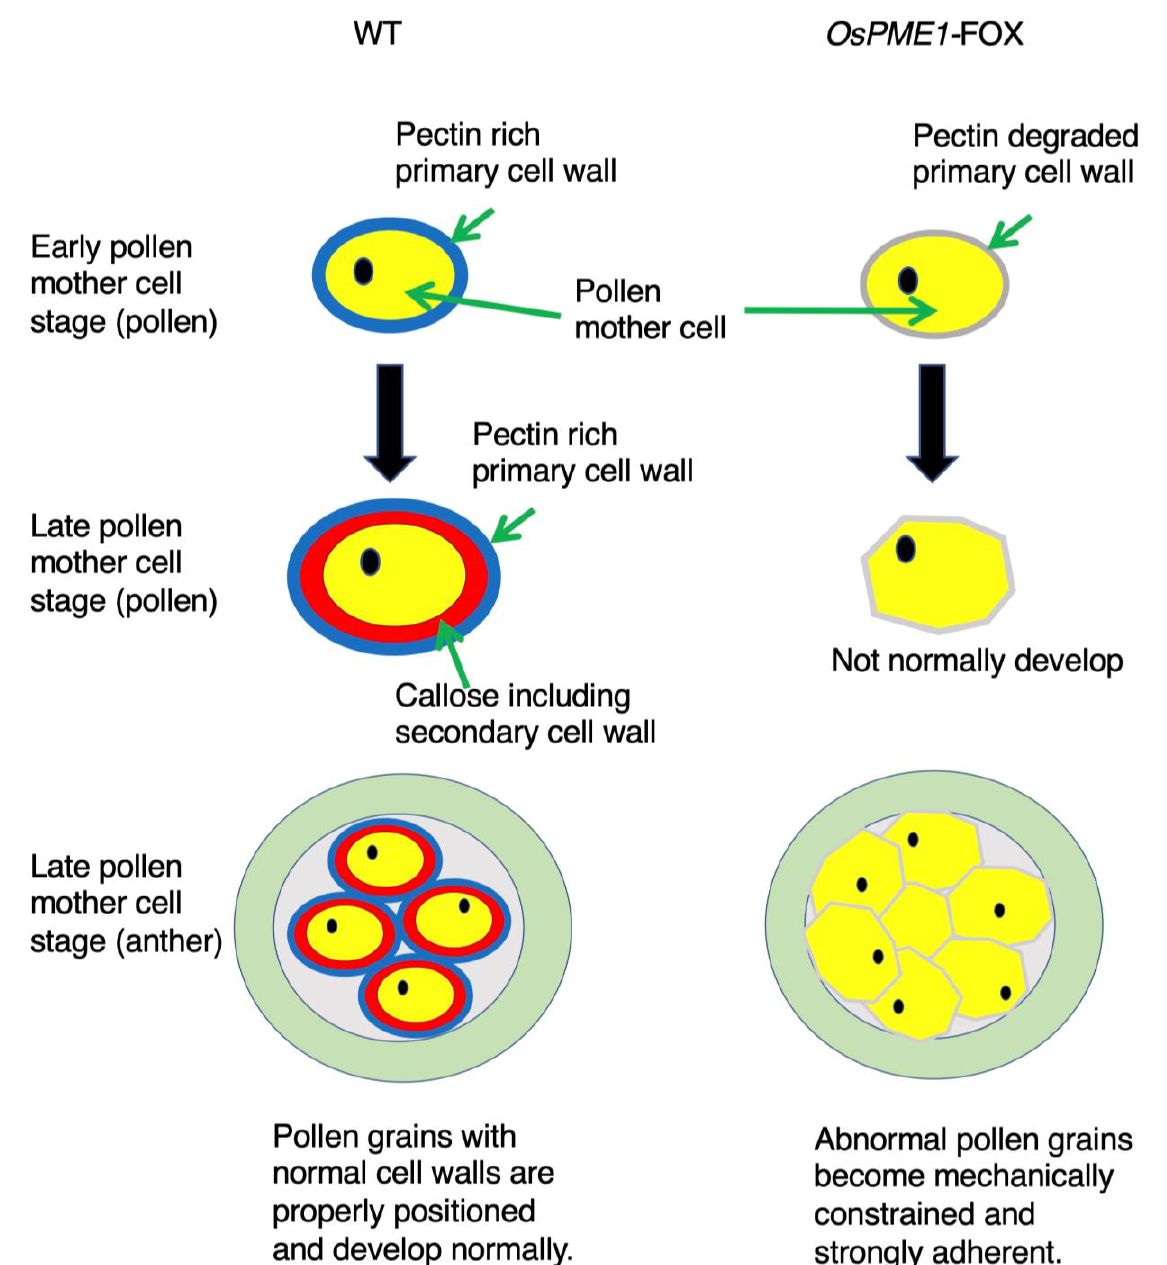
Figure 8. A model for Microspore Development in rice. The primary cell wall of the pollen mother cell has pectin. Callose is deposited between the primary wall and the plasma membrane of the pollen mother cell as the secondary cell wall. In OsPME1 -FOX, the primary cell wall of the pollen mother cell is de-graded abnormally, which may prevent the normal development of microspores. In the anther, presumably causing the developing pollen grains to become mechanically constrained and remain strongly attached to the pollen